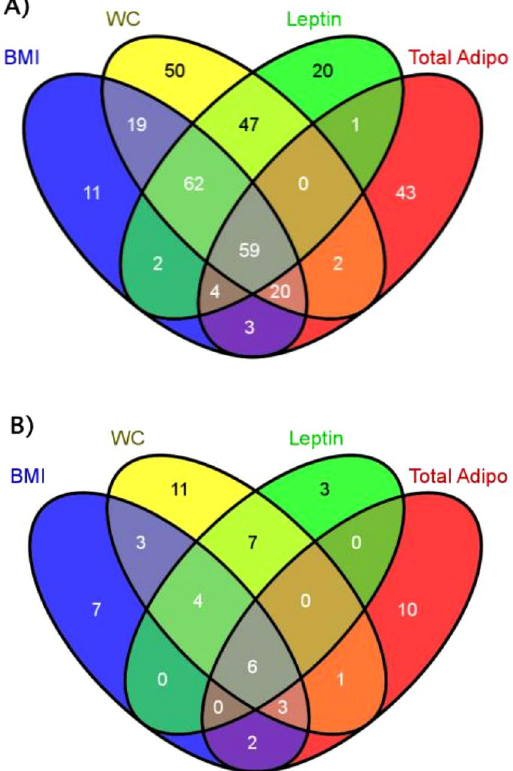
Figure 2. Venn diagrams displaying the relationship of lipids significantly associated between the traits body mass index (BMI), waist circumference (WC), leptin, and total adiponectin (Total Adipo). ( A ) Relationship of lipids with p-values < 0.05 for the traits. ( B ) Relationship of lipids with Benjamini-Hochberg p-values <